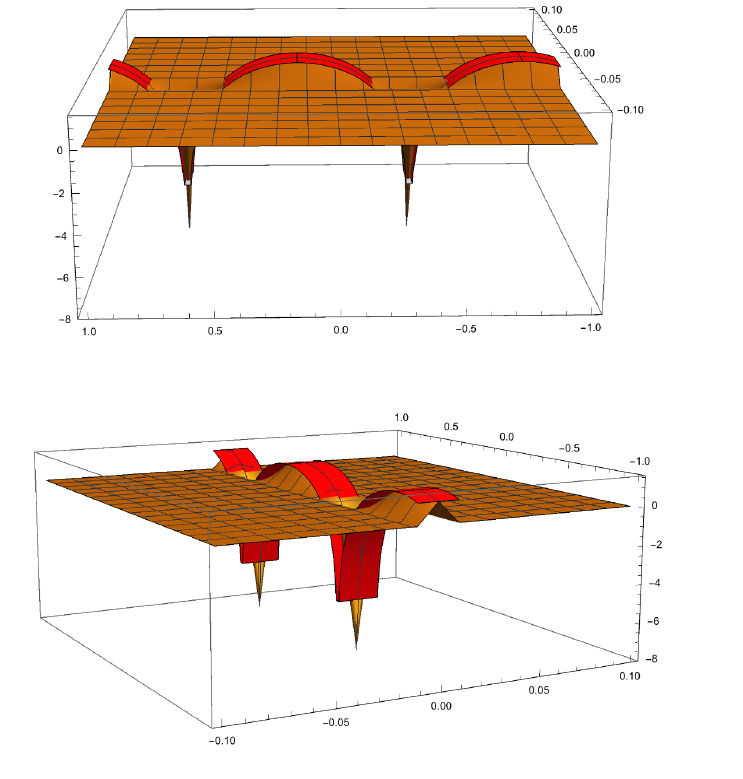
Figure 4 . An example of a wall of non-analyticity in Cardy-like limit τ → − 1